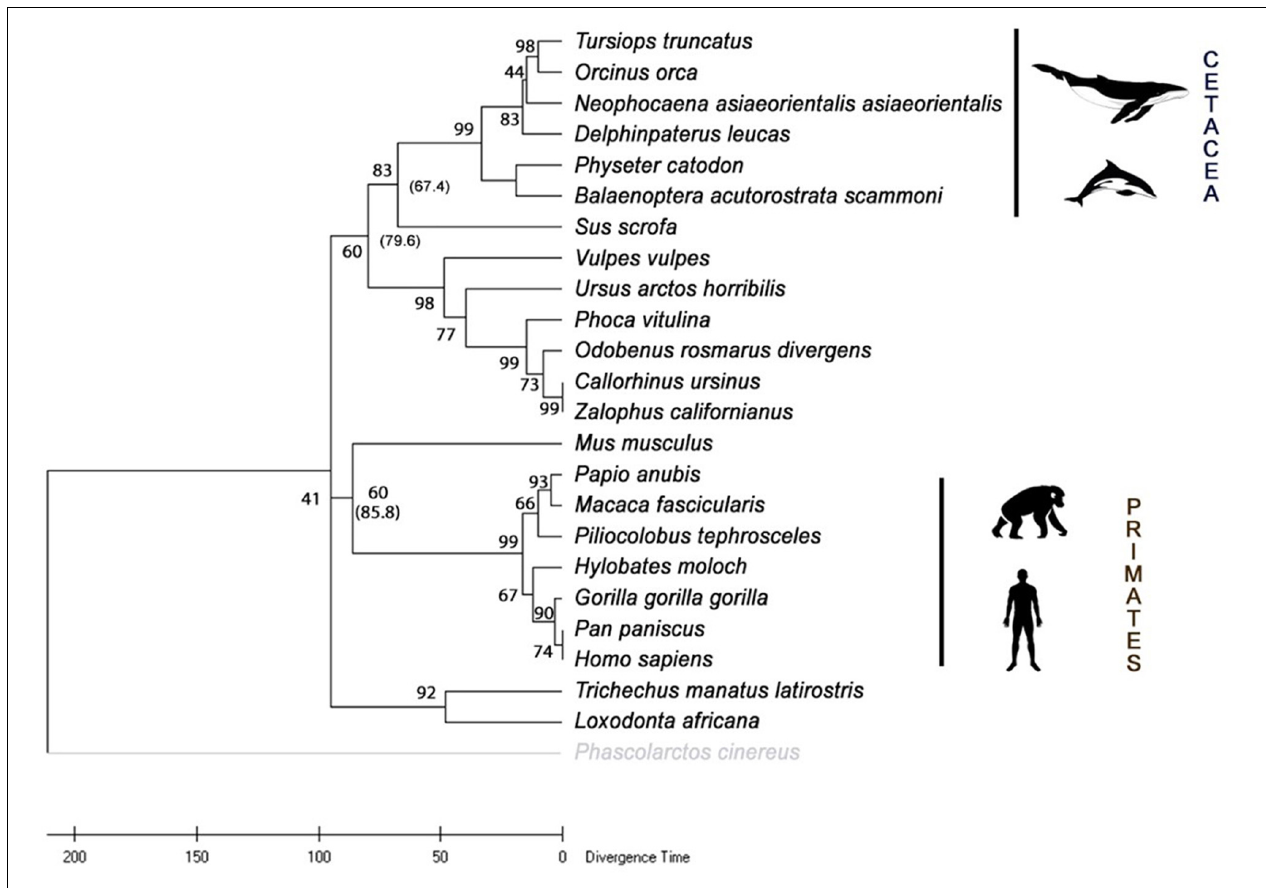
FIGURE 7 | Consensus phylogenetic tree with divergence time of various mammalian heme oxygenase-1 (HO-1). The analysis included 24 amino acid sequences. All positions with less than 95% site coverage were eliminated. There was a total of 288 positions in the final data set. The tree was rooted to the HO-1 sequence from the koala ( Phascolarctos cinereus ). Bootstrap values are indicated. Divergence time in millions of years (Mya) indicated in